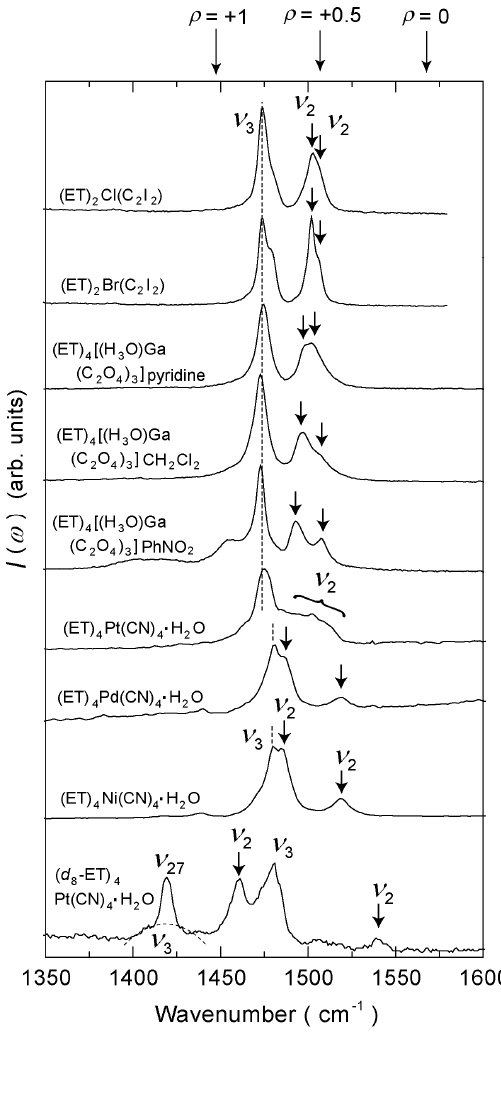
Figure 15. The ν modes of some 3/4 modes of some 3/4-filled salts at 10 K. The frequencies at filled salts at 10 K. The frequencies at ρ = 0, +0.5 2 and +1 are denoted by the arrows on the top of the panel. The incident light the arrows on the top of the panel. The incident light the arrows on the top of the panel. The incident light is along the inter-layer direction, except for